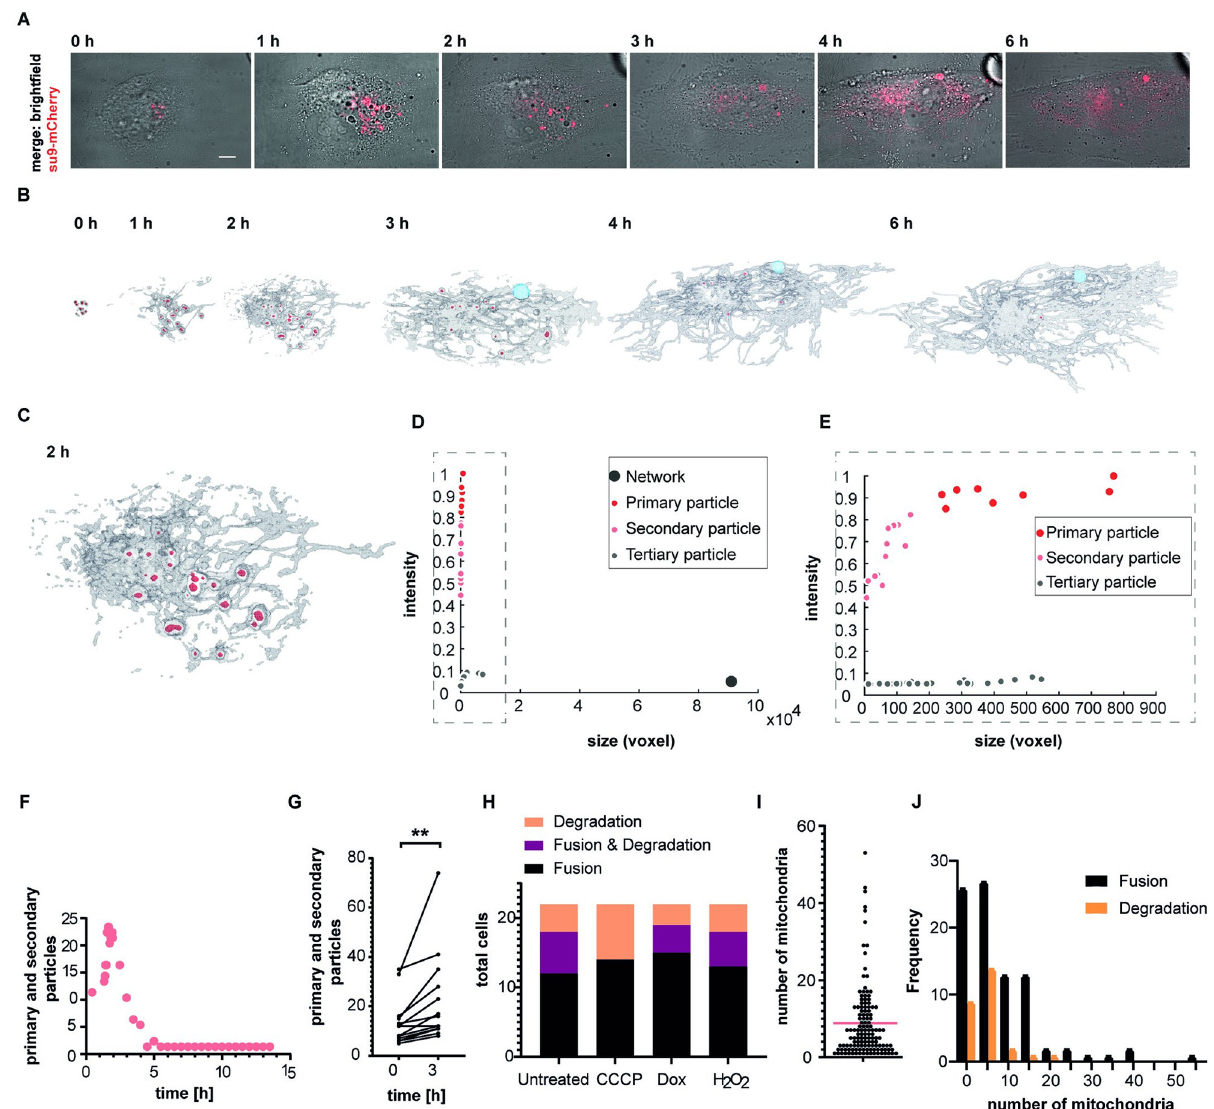
Fig 4. Mitochondrial fate in HEKa cells. ( A ) Time series of cell-to-cell transplantation from HeLa (su9-mCherry) to HEKa, fusion and degradation to the unlabeled host cell network. Scale bar: 10 μ m. ( B ) Surface-render (total su9-mCherry signal) of the time-lapse series of mitochondrial fusion and degradation within the host cell shown in a. The transplant is depicted in red, host cell mitochondrial network carrying fluorescent traces of the transplant is shown in gray, presumptive mitophagosomal structure is shown in light blue. ( C ) Enlarged section of the 2 hours time point surface render from b. ( D ) Scatter plot of size and normalized fluorescence intensity distribution of objects detected at the 2-hour time point. ( E ) Zoom in on low-size fraction of the scatter plot shown in c. ( F ) Total number of objects classified as primary transplant or secondary particle over time. ( G ) Absolute number of primary and secondary particles detected directly after transplantation (0 hour) and after 3 hours for 12 cells. Paired t test, p = 0.0095. ( H ) Fusion and degradation behavior of drug-compromised mitochondrial transplants in HEKa cells. Each condition was tested with 22 cells. ( I ) Distribution of mitochondrial quantity transplanted per cell from all conditions tested in e, total number of cells: 132. Dashed line indicates mean value. Total number of transplanted mitochondria: 1,117. ( J ) Histogram plot correlating the amount of transplanted mitochondria with uptake outcome; bin width is 5. Correlation of the absolute number of transplanted mitochondria per cell with the cell response of either mitochondrial fusion or degradation across all transplant conditions in percent. Total cell number: n = 135. The data underlying Fig 4D–4J can be found in S1 Data. HEKa, human endothelial